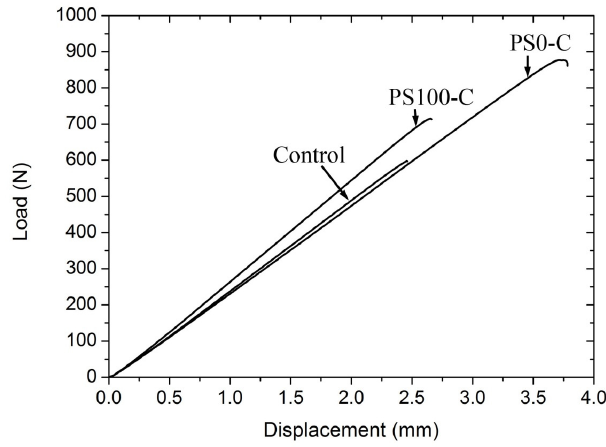
IC with crack length.